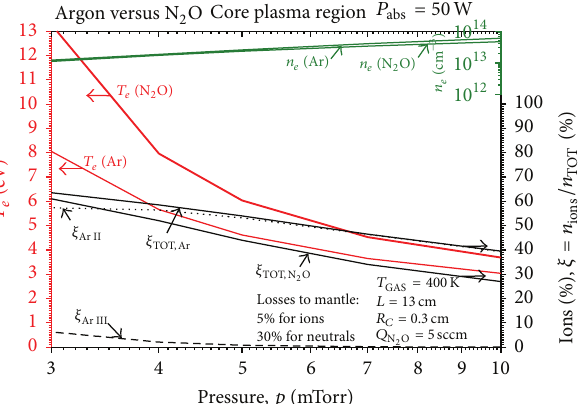
Figure 3: As in Figure 2 but for 𝑇 𝑒 , ionization percentage ( 𝜉 ), and remaining N 2 O percentage.